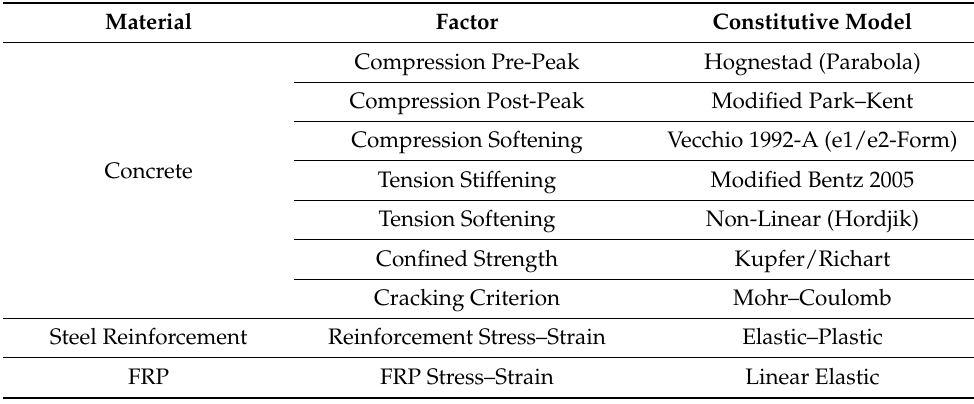
Table 1. Materials Models for Concrete, Reinforcing Steel, and FRP [30,31].